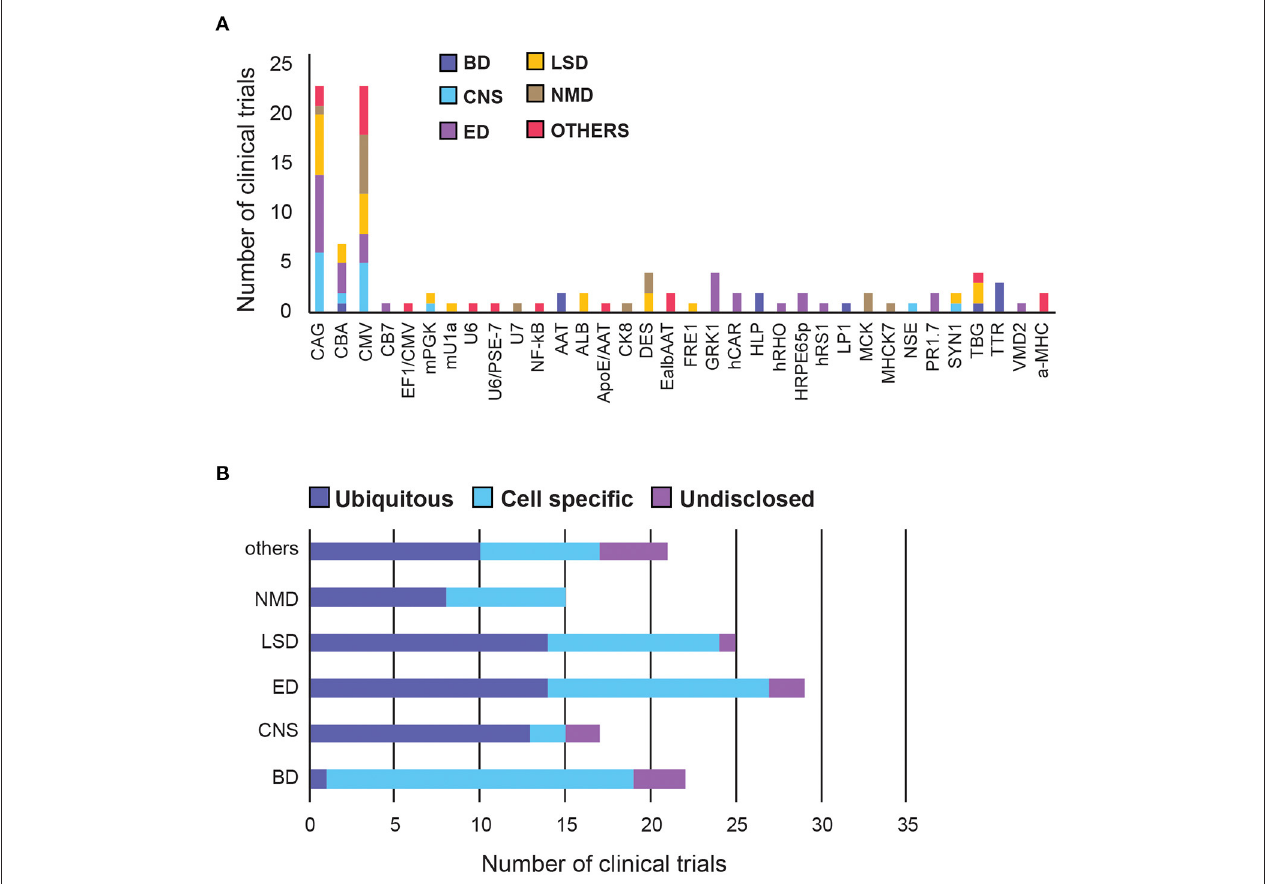
FIGURE 5 | A summary of promoter choice for AAV gene therapy delivery in clinical trials. (A) Overall promoter distribution in all clinical trials. (B) Promoter type across therapeutic areas. BD, Blood disorders; CNS, Central Nervous System; ED, Eye Disorders; LSD, Lysosomal storage disorders; NMD, Neuromuscular Disorders. The list of promoter abbreviations can be found in Supplementary Table 3 , Supplementary Figure 2